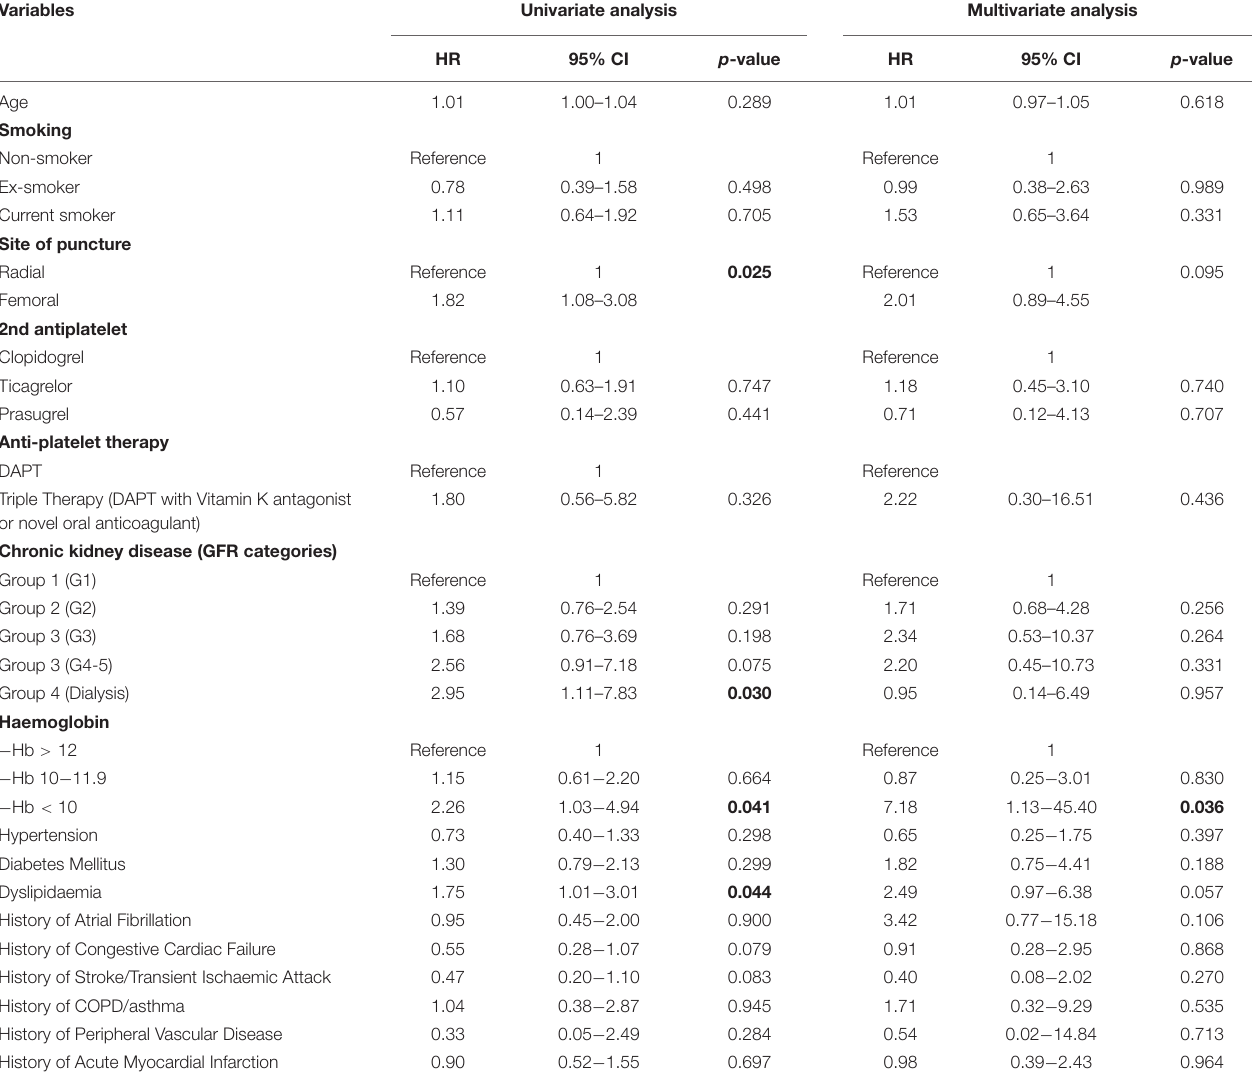
TABLE 3 | Cox regression analysis of predictors of significant bleeding events (Bleeding Academic Research Consortium Type 3 or worse). Variables Univariate